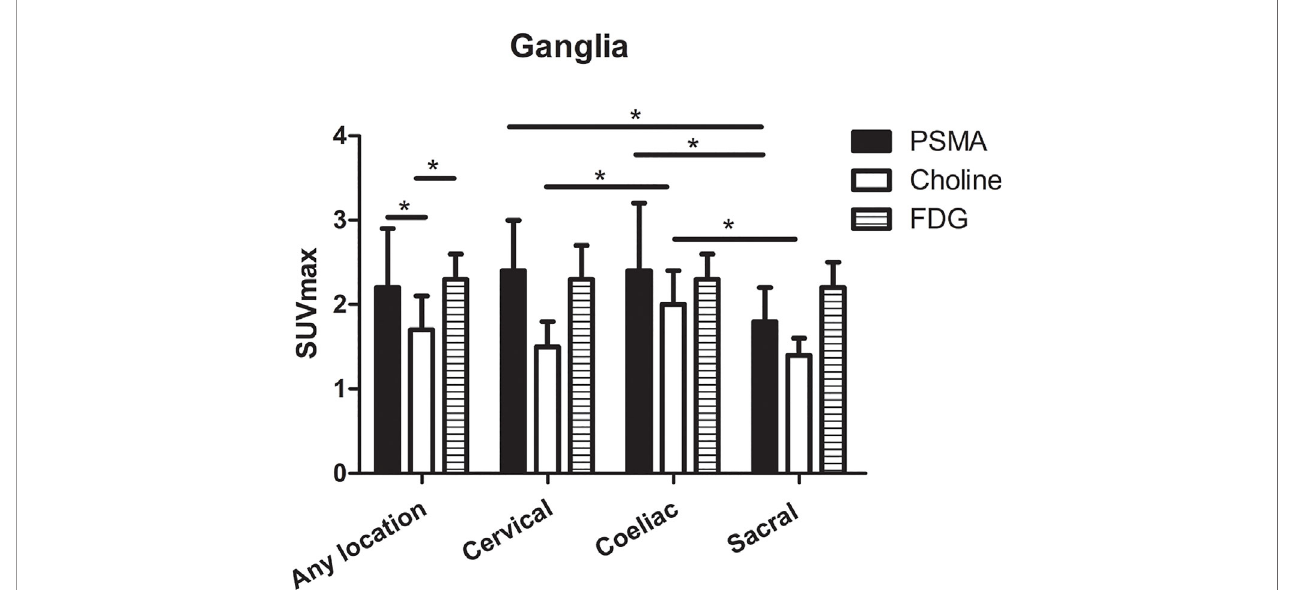
FIGURE 3 | The SUVmax of PSMA-PET, choline-PET and FDG-PET at any location, and cervical, coeliac, and sacral ganglia. *P < 0.05.